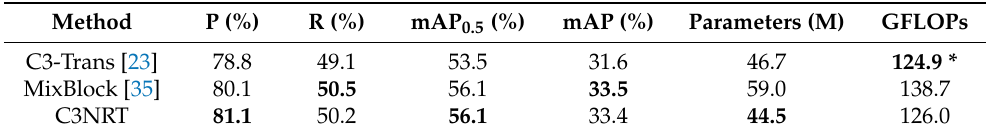
Table 6. Comparison results between C3NRT and other Transformer